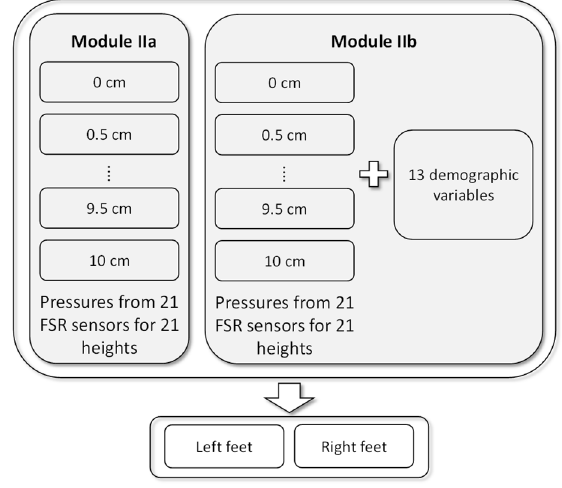
Figure 5. Flowchart for selecting final model for modules.